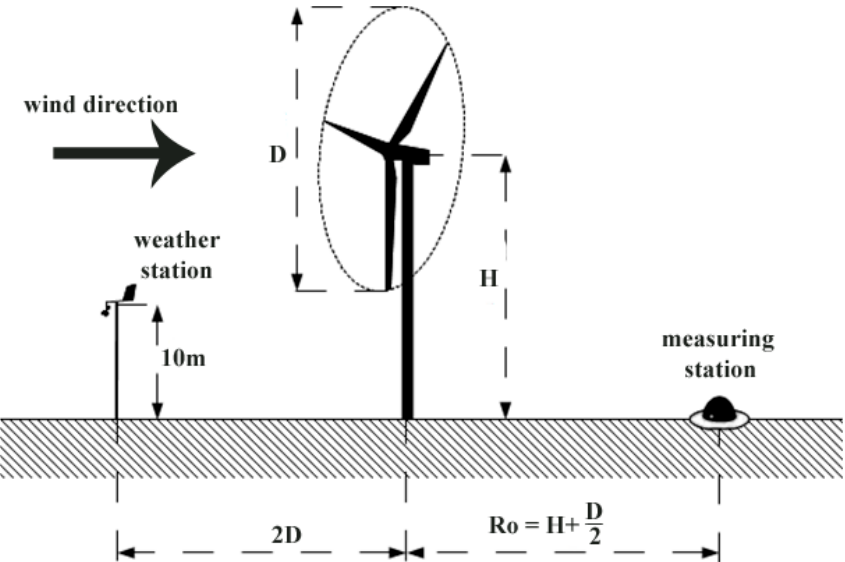
Figure 1. Relative positioning of microphone and weather station in relation to the WT, as per the PN-EN 61400-11